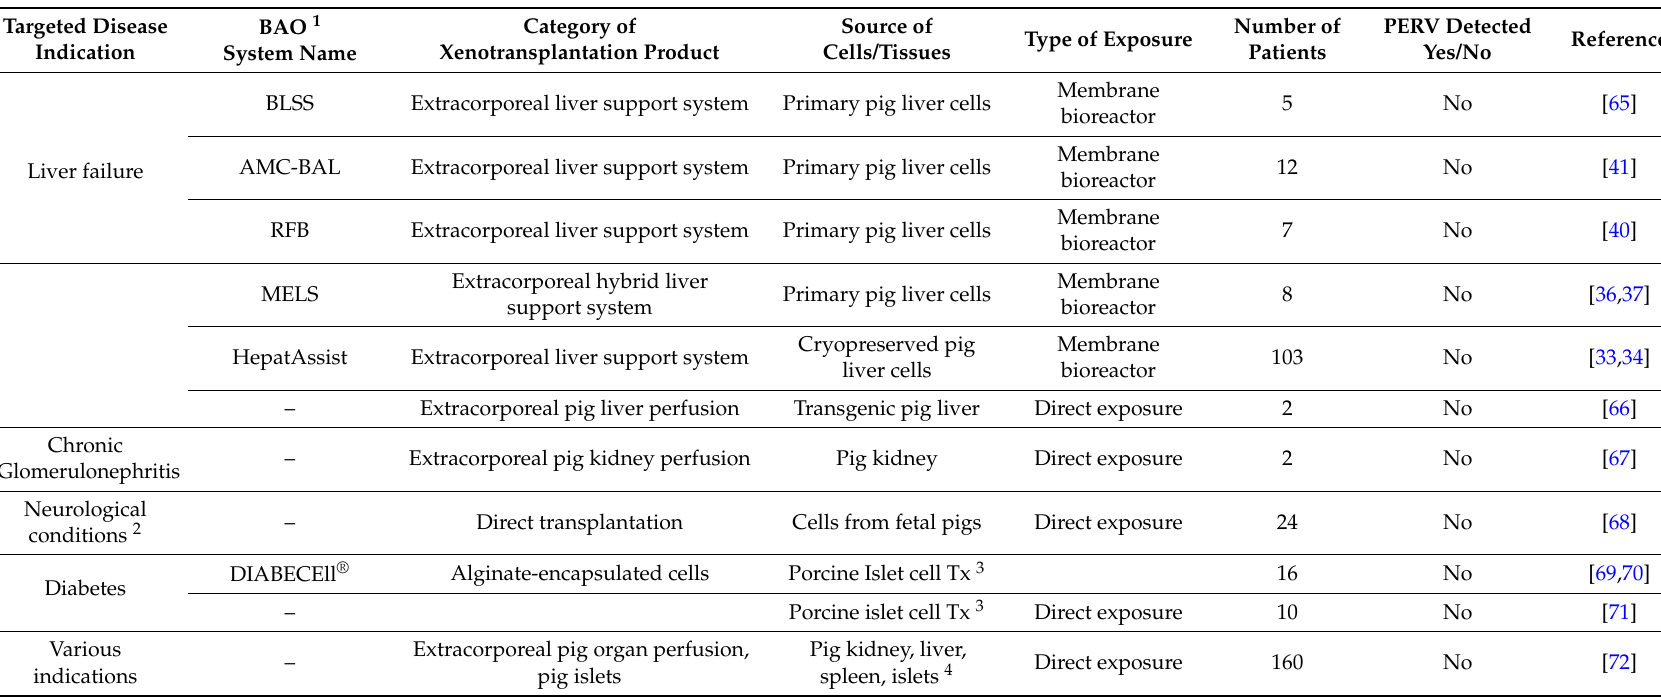
Table 1. Summary of porcine endogenous retrovirus (PERV) testing from patients exposed to bioartificial organs containing pig cells and to pig organs or tissues. Targeted